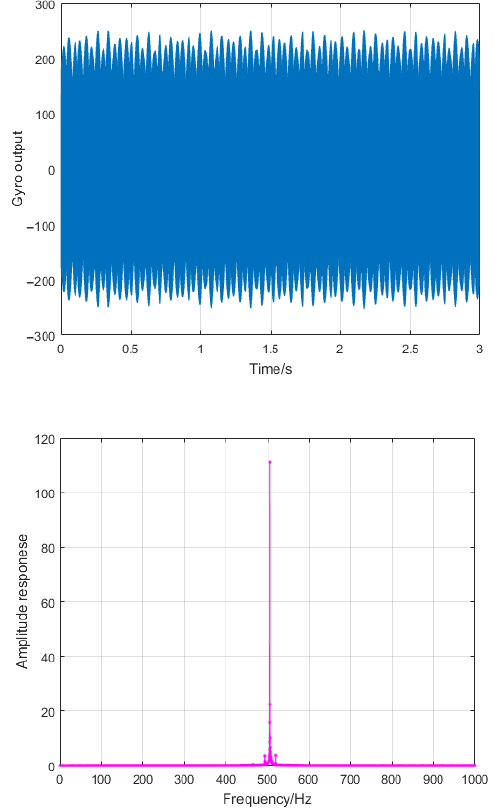
Figure 2. The original information and spectrum analysis results of the laser gyro ( f s = 2k Hz, f D = 515 ).